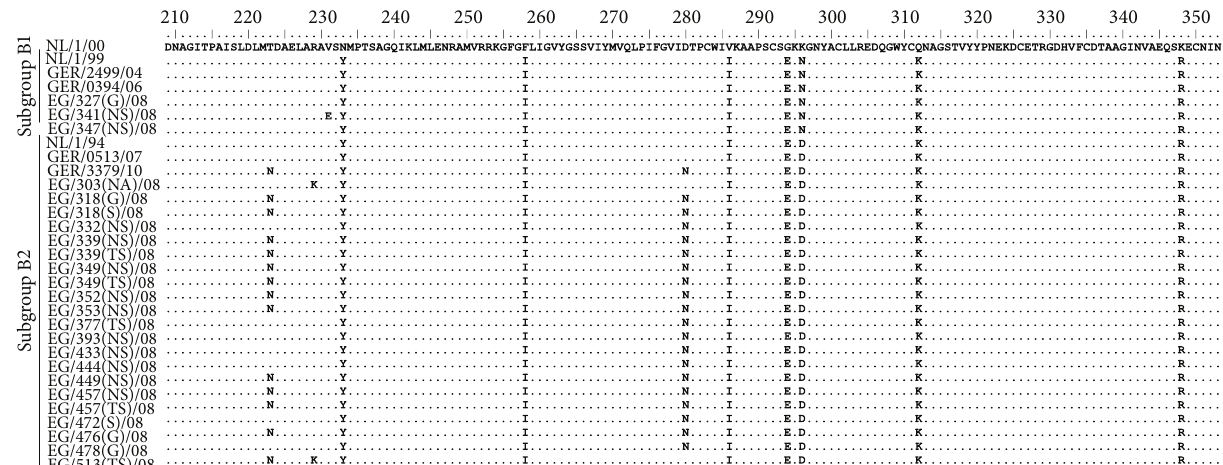
Figure 4: Amino acid alignment of partial F protein gene of HMPV. Predicted amino acid sequences of Egyptian HMPV B were compared with the corresponding sequence of the prototype strain NL/1/00 (GenBank accession number AF371337). Identical residues are indicated by dots. The Egyptian HMPV is identified by the geographic location (EG), patient number, type of specimen, and year of